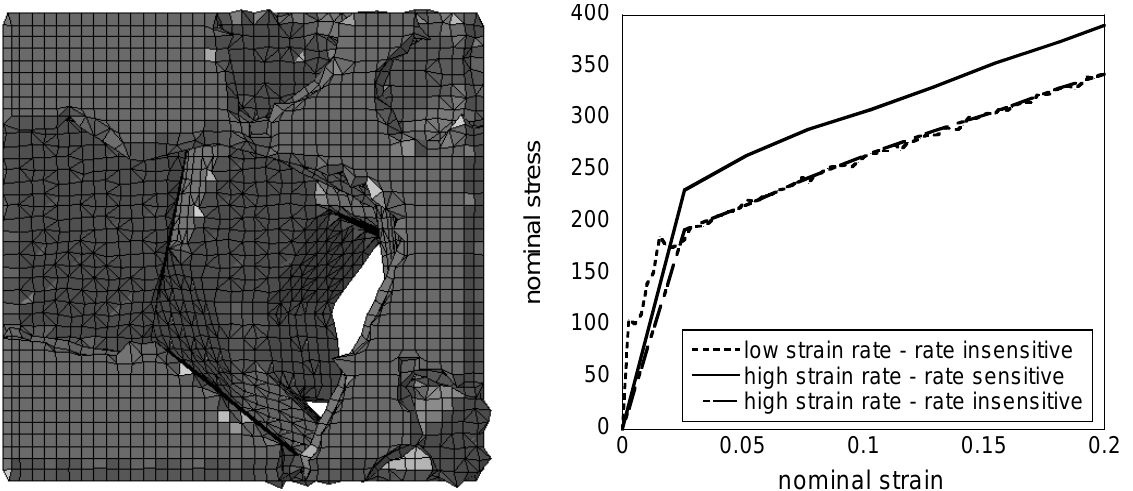
Figure 4. ( Left ) mesh of a virtual foam of relative density 0.49  ; ( Right ) FE predictions of the macroscopic material responses.